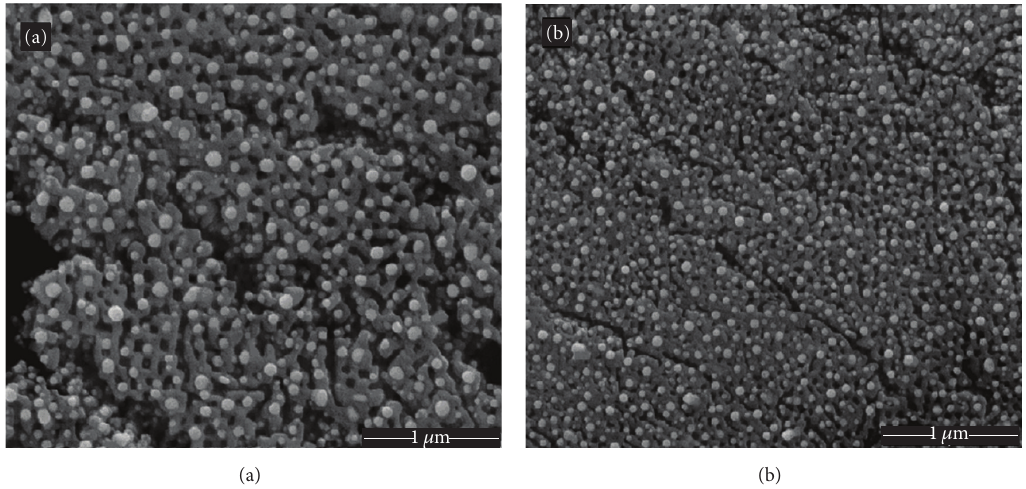
F 2: SEM images of pure (a) and nitrogen-doped (b) TiO